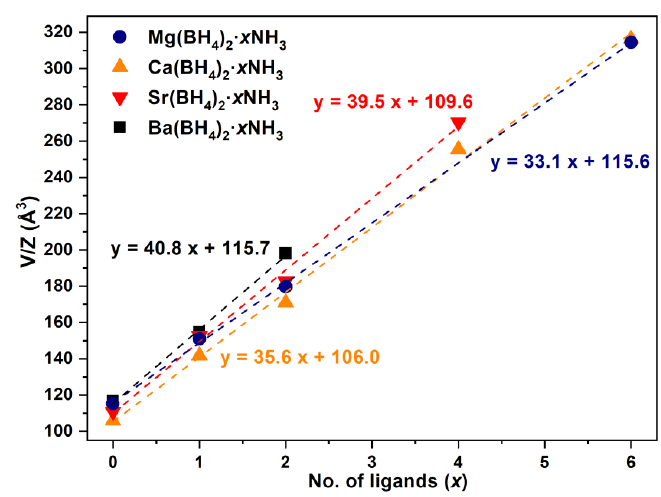
Figure 3. Volume per formula unit ( V/Z ) as a function of ammonia content in Mg(BH 4 ) 2 · x NH 3 ( x = 1, 2, 3, 6) (blue circles), Ca(BH 4 ) 2 · x NH 3 ( x = 1, 2, 4, 6) (orange triangles), Sr(BH 4 ) 2 · x NH 3 ( x = 1, 2, 4) (red inverted triangles) and Ba(BH 4 ) 2 ∙ x NH 3 ( x = 0, 1, 2) (black squares).